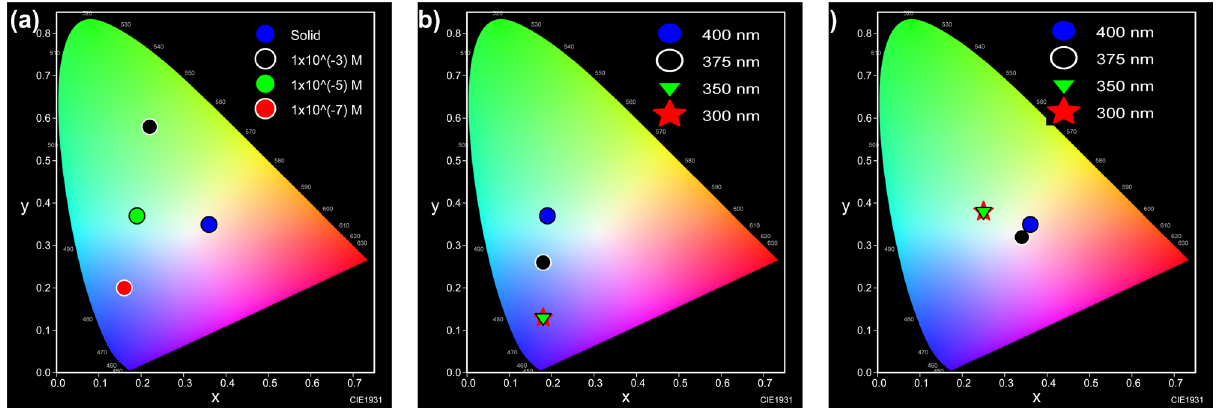
Figure 14. ( a ), ( b ), and ( c ) are the CIE chromaticity diagrams of the emission colors obtained from the spectra in Fig. 13a (the solid and different solution concentrations), Fig. 13b (different λ ex of the solution), and Fig. 13c (different λ ex of the solid),